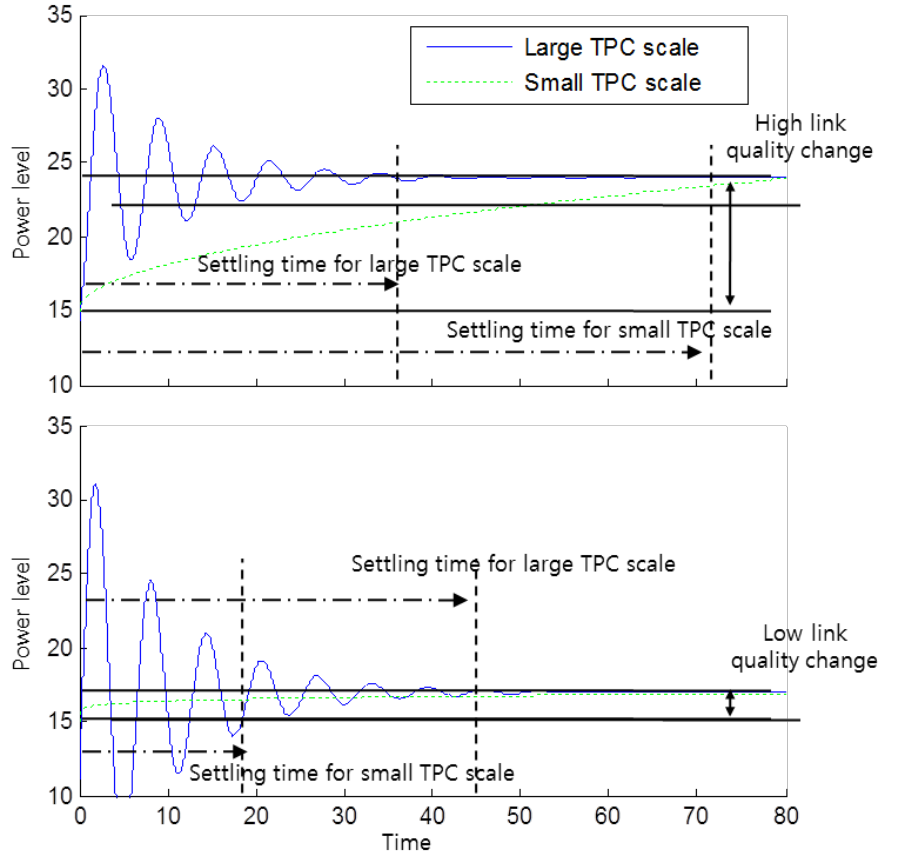
Figure 7. The correlation of the control scale and settling